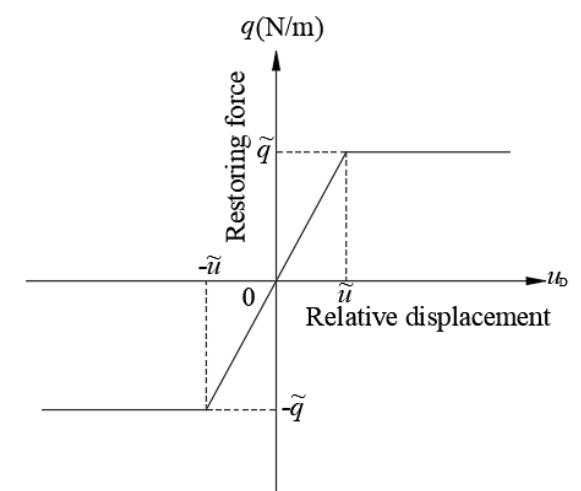
q and D u . Figure 4. Linear and nonlinear relationships between q and u D